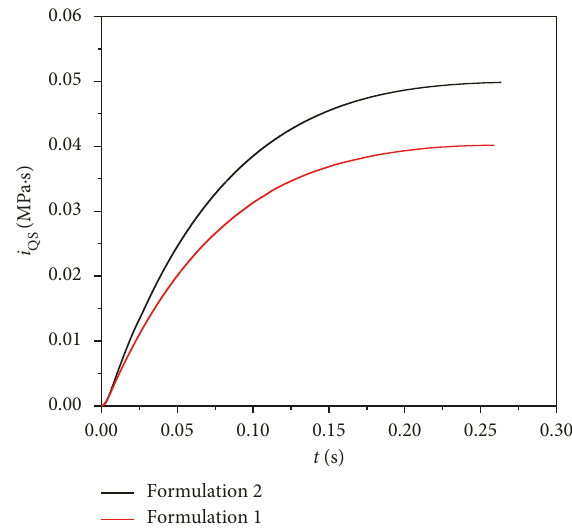
Figure 8: Impulse-time curve of the quasistatic pressure.